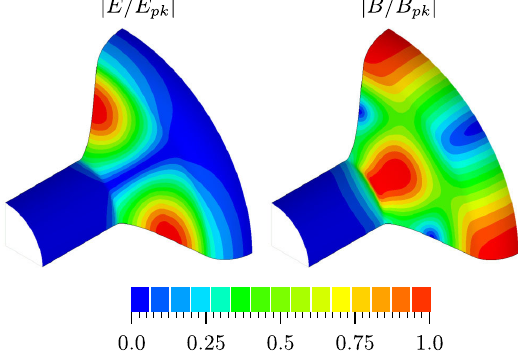
FIG. 3. Normalized fields distribution of the TM 210 mode on the surface of an elliptical cavity